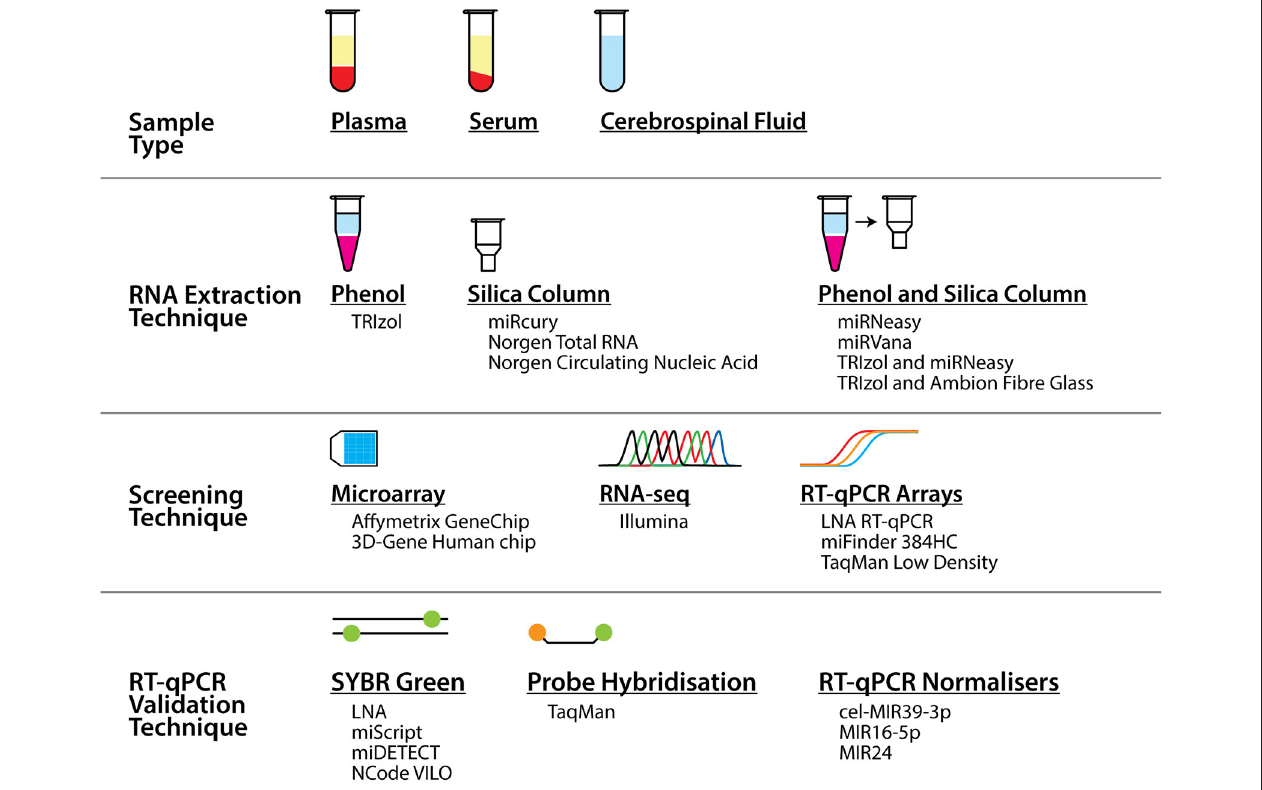
FIGURE 1 | Summary of the different sample types, techniques, and tools that were used to profile miRNA biomarkers in ALS in the studies presented in this review. As can be seen alongside Table 1 , numerous different combinations of these sample types and tools across the techniques were employed across a number of studies.